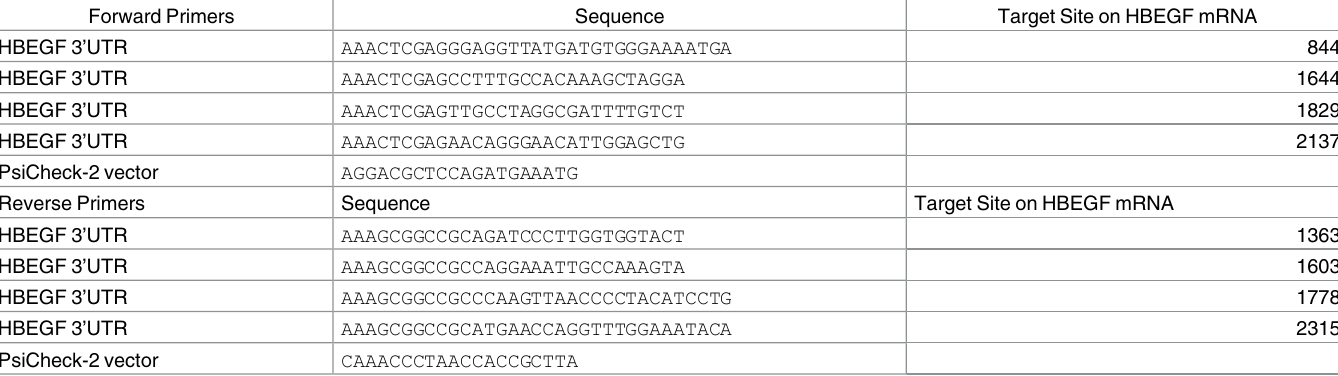
Table 1. Primer sequence for amplification of HBEGF 3’UTR and vector